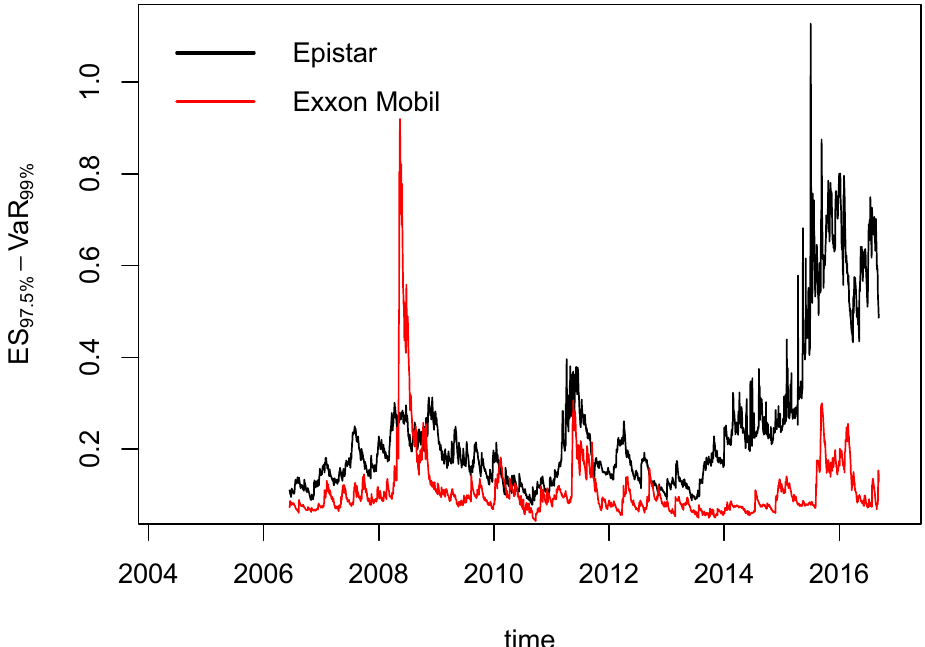
Figure 4. The difference in risk measures in Epistar and Exxon Mobil stock returns.